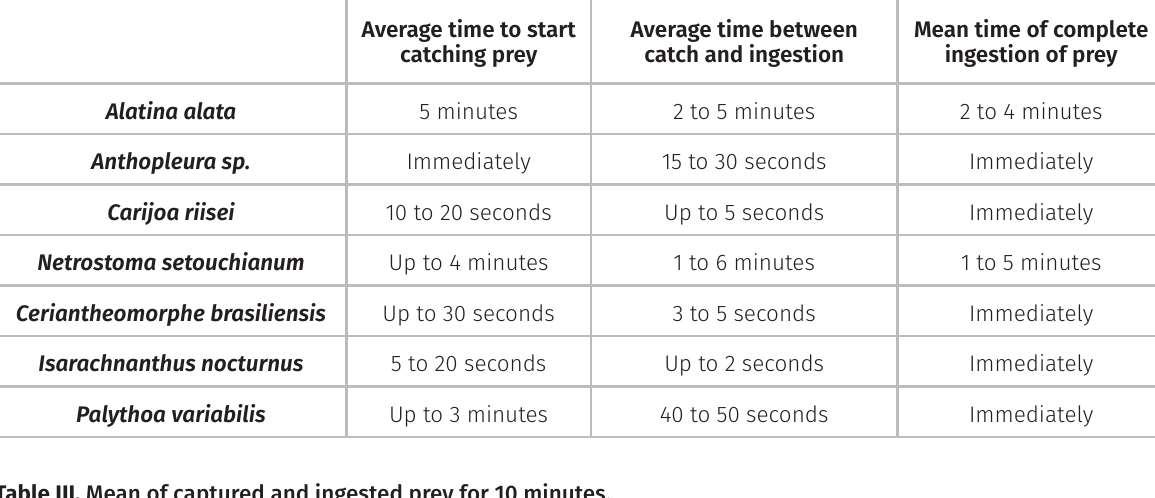
Table III. Mean of captured and ingested prey for 10